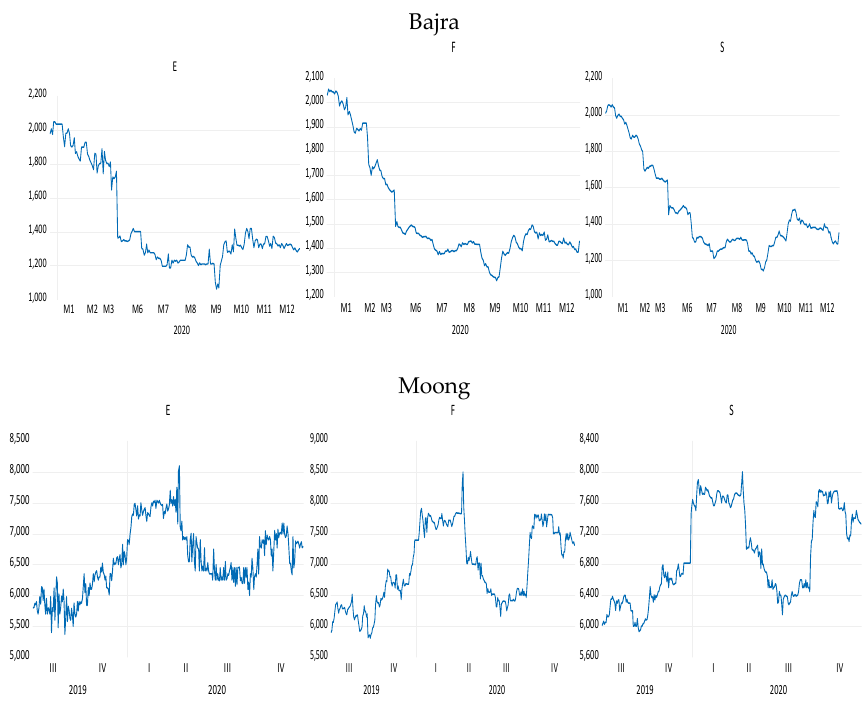
Figure A1. The daily spot prices of the E-NAM market, the future, and the spot prices of the NCDEX. Table A1. Descriptive Statistics of price series of all the commodities. Commodity